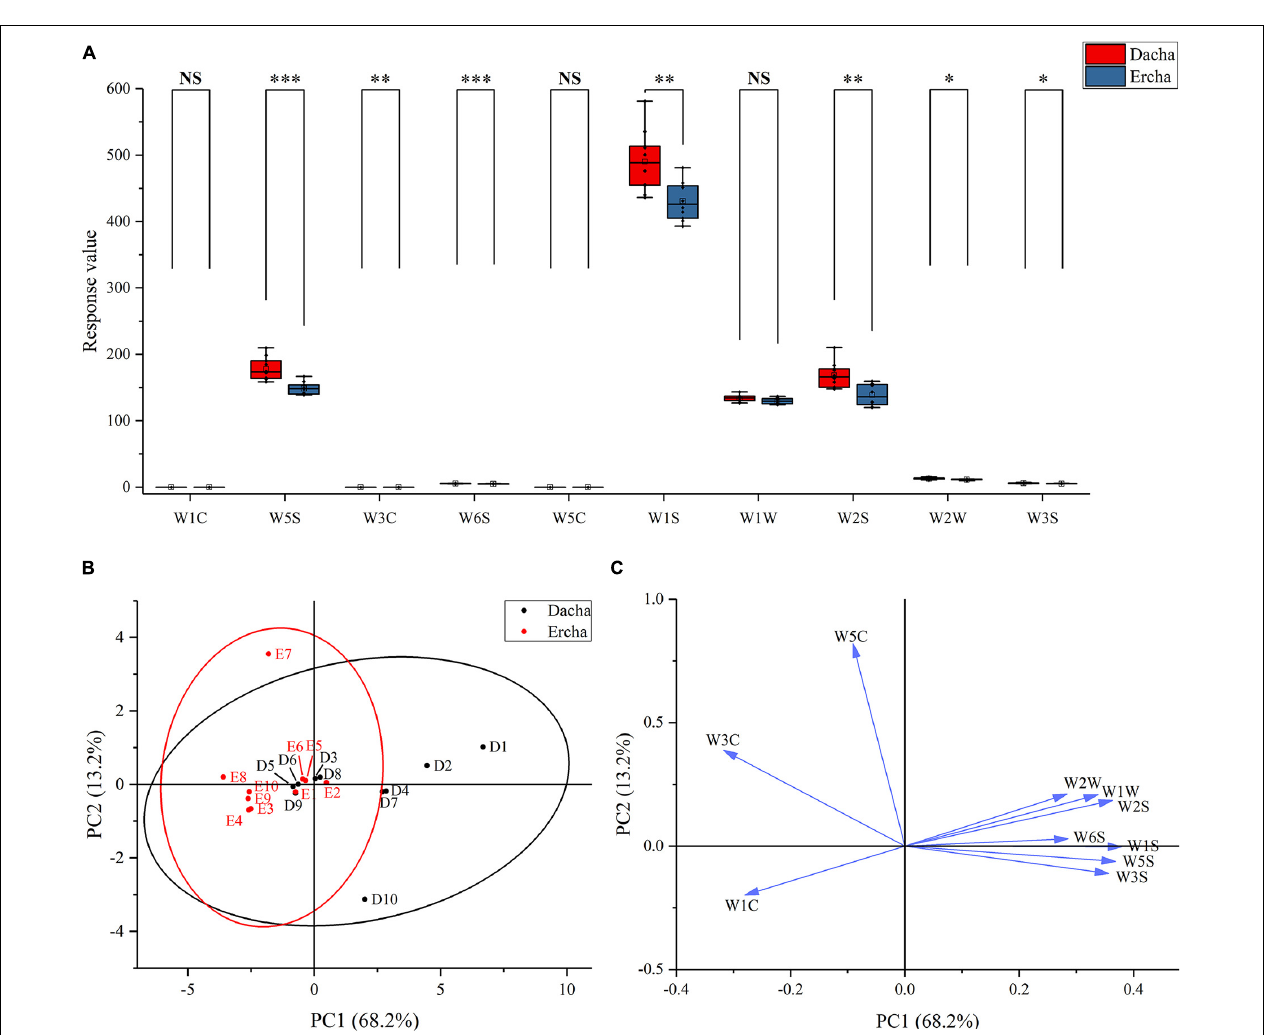
FIGURE 8 | Box plot (A) of response value of electronic nose, score plot (B) , and loading plot (C) of PCA (NS: P > 0.05, ∗ 0.01 < P < 0.05, ∗∗ 0.001 < P < 0.01, ∗∗∗ P < 0.001).